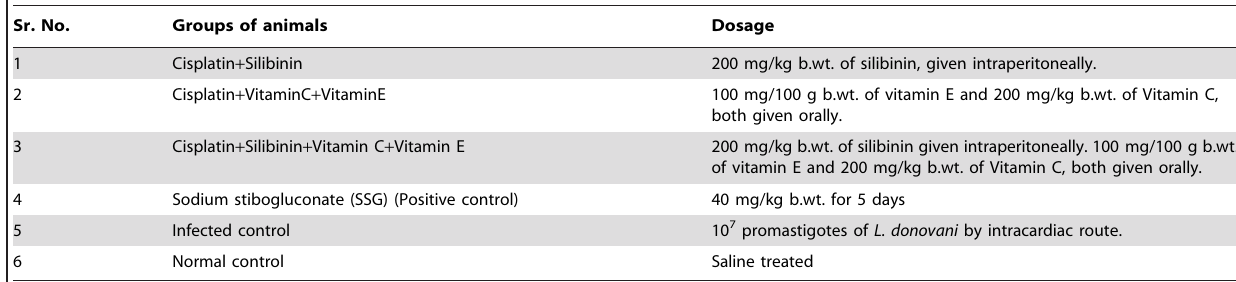
Sr. No. Groups of